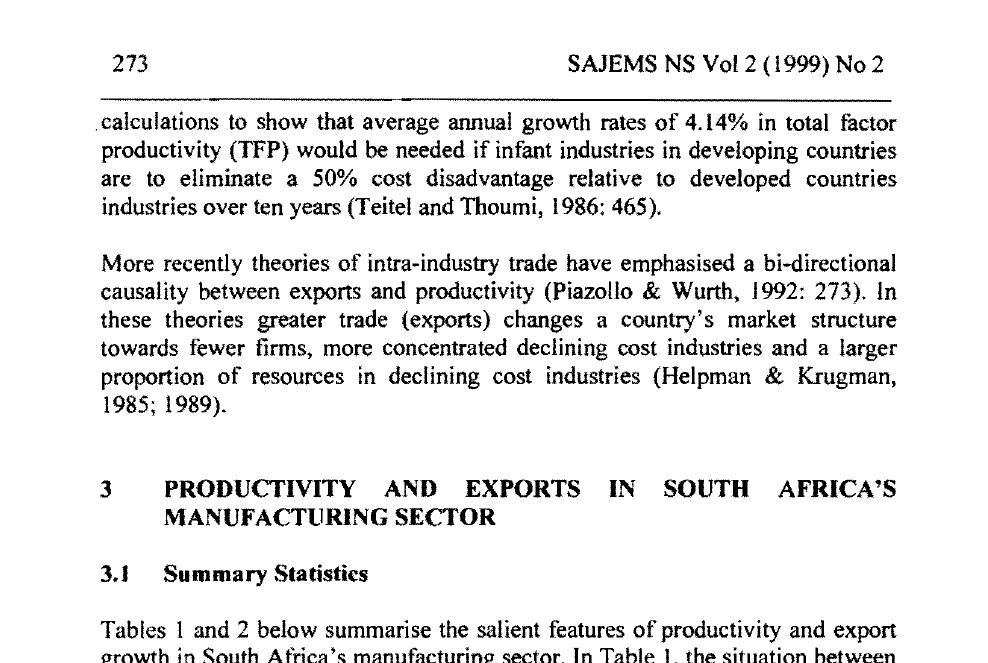
Output, Produdivity and Exports in ManuCaduring, 1972 - 1990, (Average Annual Growth %)